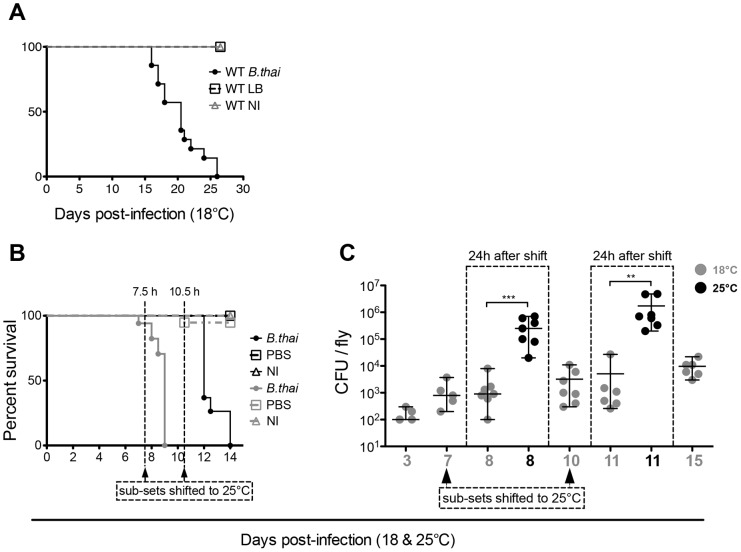

B. thailandensis growth at 18°C is slower than at 25°C.(A) Survival of wild-type flies infected with wild-type B. thailandensis E264 and kept at 18°C. (B) Infected and control flies were kept at 18°C, and subgroups were shifted to 25°C at time points 7.5 and 10.5 days after infection. Dead flies were counted twice a day. The result indicates that bacteria recovered at 25°C, and killed the flies fast. (C) B. thailandensis was injected at an initial dose of OD600 = 0.01. Flies were kept at 18°C (grey) and shifted to 25°C (black) at time points 7 and 10 days p.i. Subsets of equally treated flies were kept at 18°C as controls (grey). Samples were homogenised 24 h after shifting from 18 to 25°C to determine the growth of bacteria inside the flies. Samples were analysed at time points 3, 7, 8, 10, 11, and 15 days p.i. Bacterial growth was determined by plating dilutions of homogenised infected and control flies in PBS. Plated bacteria were left at 37°C for 24 h, when bacterial colonies were counted. Data is based on one experiments; n = 7 flies. Statistical significance of bacterial growth was determined using Mann-Whitney test (GraphPad Prism); ** p<0.002, *** p<0.001. Y-axis  =  log10.